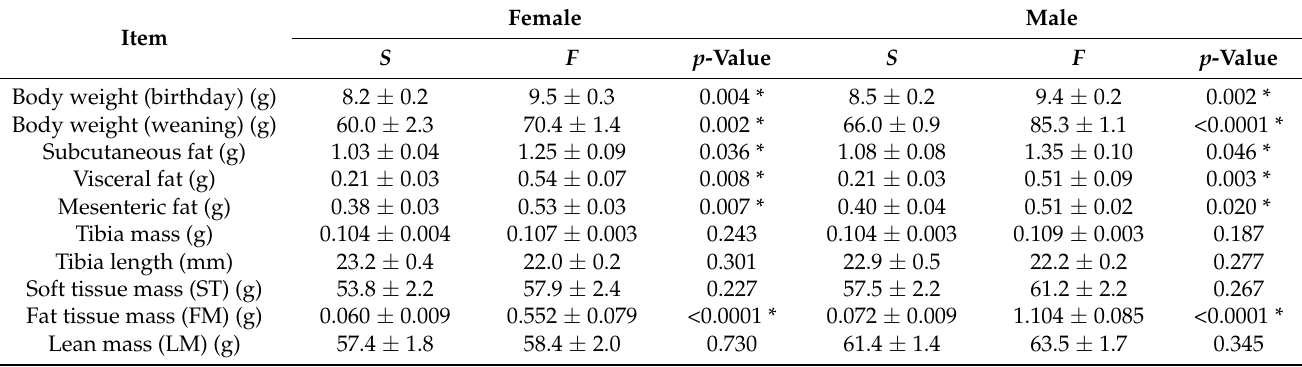
Table 2. The body weight (birthday and at weaning), masses of fat tissue depots, weight and length of tibia and parameters of body composition of female and male rats on the weaning